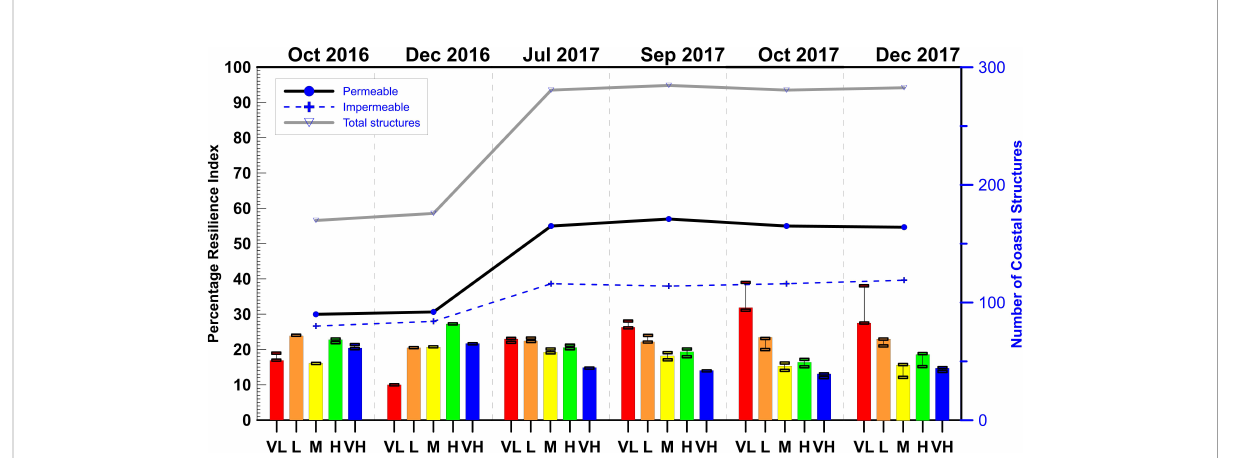
FIGURE 8 Histogram representing the percentage of transects within each category of the Coastal Resilience Index (VL: Very Low in red, L: Low in orange, M: Medium in yellow, H: High in green and VH: Very High in blue). Bar lines represent the variability range related to the selection of beach slope using the 0.05 and 0.15 values. Lines (right axis) represent the evolution of the number of coastal structures at each surveyed date within the study area. The gray line represents the total number of coastal structures, the black line represents the number of permeable structures, and the blue dotted line represents the number of impermeable